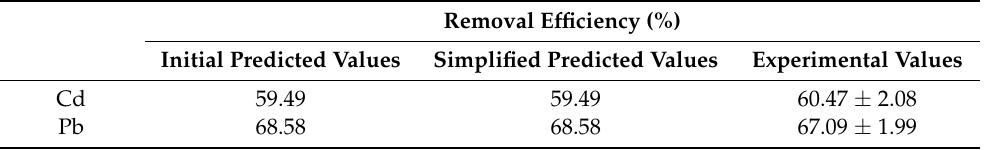
Table 5. Predicted and experimental values of removal efficiency at optimum conditions. Removal Efficiency